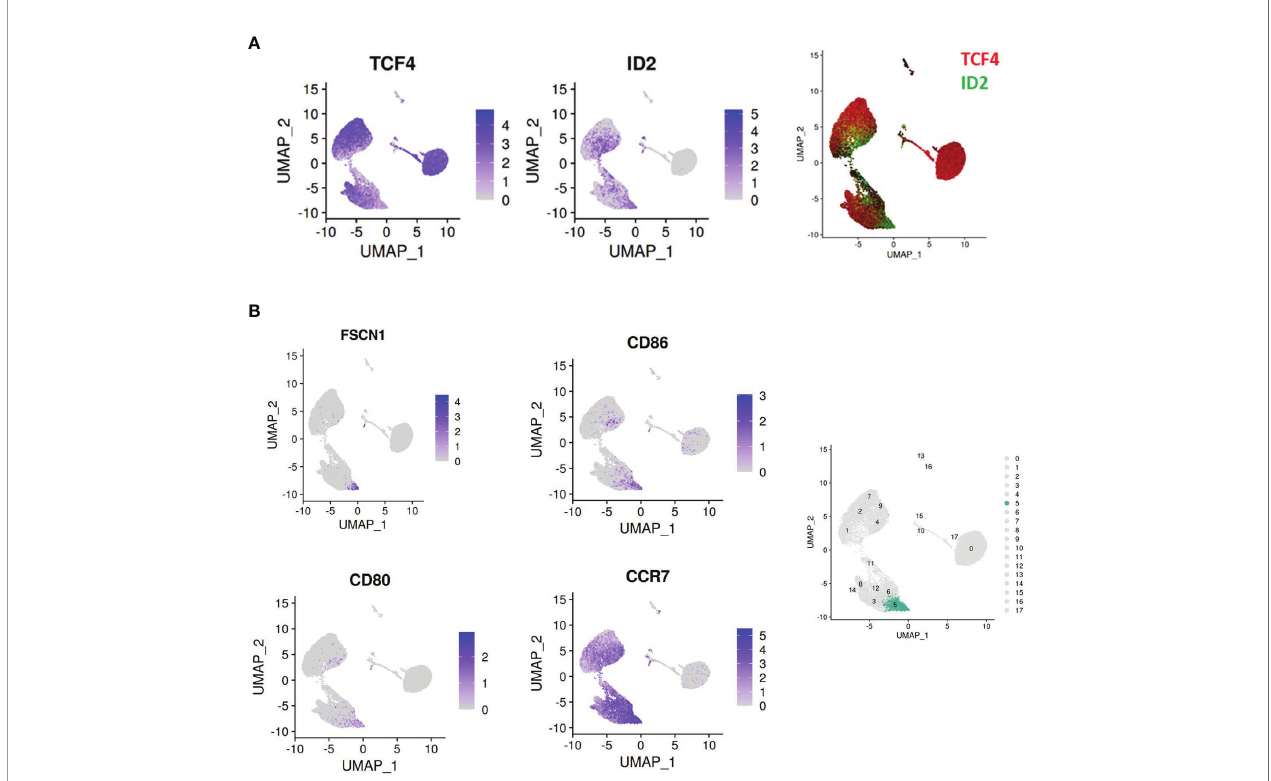
FIGURE 5 | Dynamic regulation of master transcription factors across pDC clusters. (A) An inverse relationship is observed between the pDC master regulator TCF4 and the TCF4 antagonist ID2. The cluster 1/11 isthmus is notable for loss of TCF4 and gain of ID2. (B) Cluster 5 (highlighted in the right panel) is notable for upregulation of ID2, and the cDC/APC markers CD86, CD80, FSCN1 and CCR7.